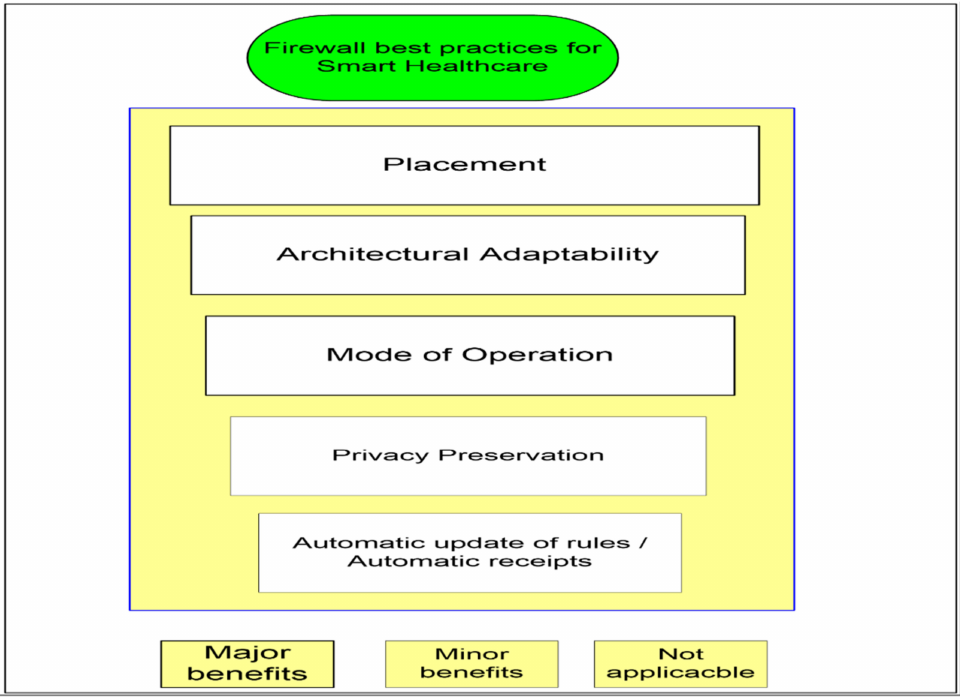
Figure 8. Firewall best practices for smart healthcare